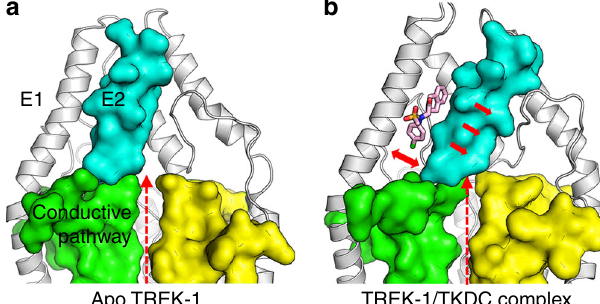
Fig. 5 Different conformations of TREK-1 obtained from MD simulations. a Conformation of TREK-1 in the apo system S apo . b Conformation of TREK-1 in the complex system S complex with TKDC. The protein is shown as a cartoon. The extracellular E2 helix ( cyan ) and the selectivity fi lter below ( green and yellow ) are shown as surfaces. The fi lter in green and the E2 helix in cyan are in the same subunit. The yellow fi lter is in the other subunit. TKDC is shown as sticks. The red dashed arrow represents the conductive pathway. The red solid arrows indicate the movement of the E2 helix under the in fl uence of TKDC. All illustrations are from the end of simulation